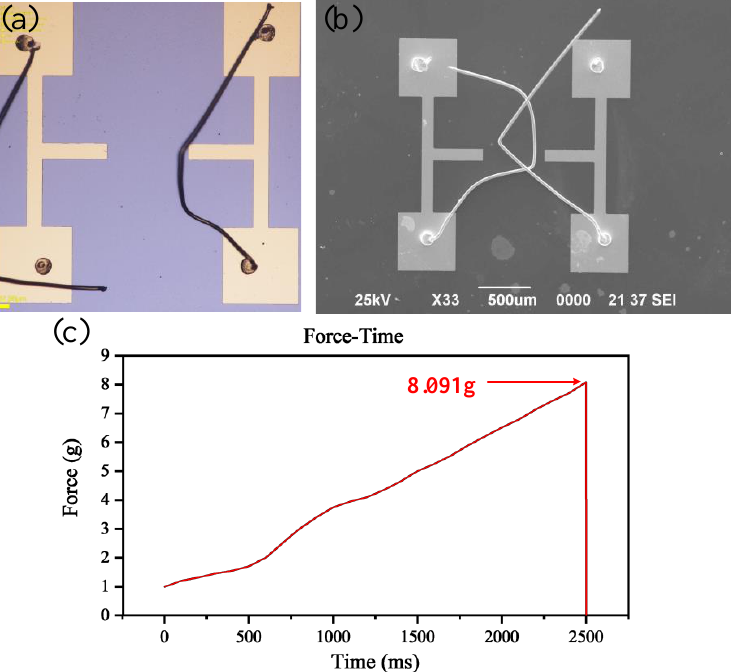
Figure 4. Pull failure experimental results observed under the optical microscope and scanning electron microscope and photo of shear force test. ( a ) Optical microscope image after tensile test. ( b ) SEM image after tensile failure test. ( c ) Time-force diagram of shear force test.